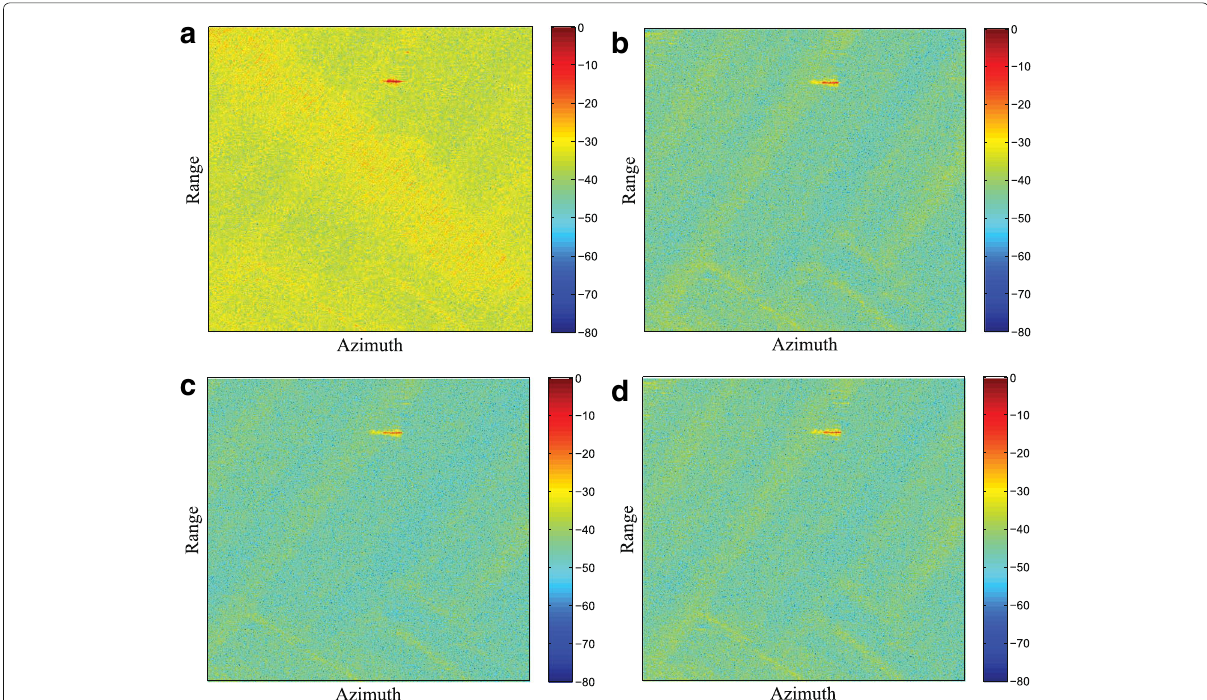
Fig. 14 Enlargements of the yellow dotted zones of Fig. 14. a The ambiguity-plus-noise levels achieved by Krieger DBF. b The ambiguity-plus-noise levels achieved by IDBF. c The ambiguity-plus-noise levels achieved by ImpMMSE. d The ambiguity-plus-noise levels achieved by our adaptive